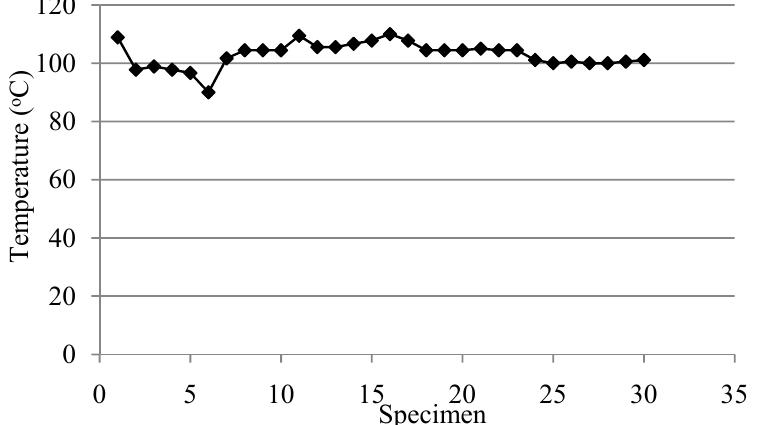
Figure 4. Interface temperature between workpiece and abrasive belt as measured by a thermographic A20V